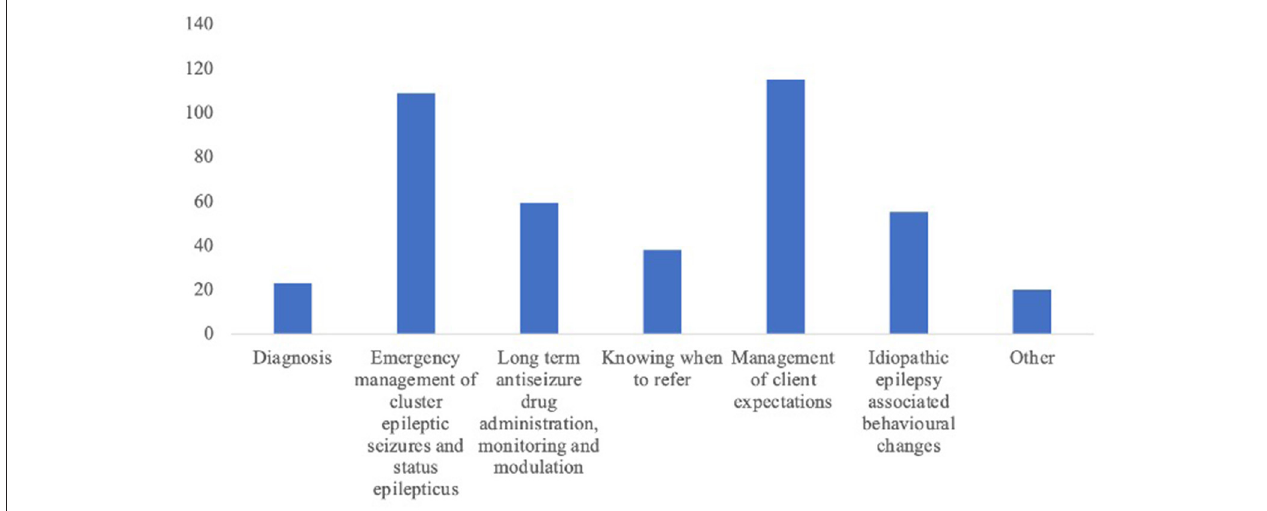
FIGURE 3 | A bar chart displaying which aspects of canine idiopathic epilepsy the 235 respondents felt most challenging.